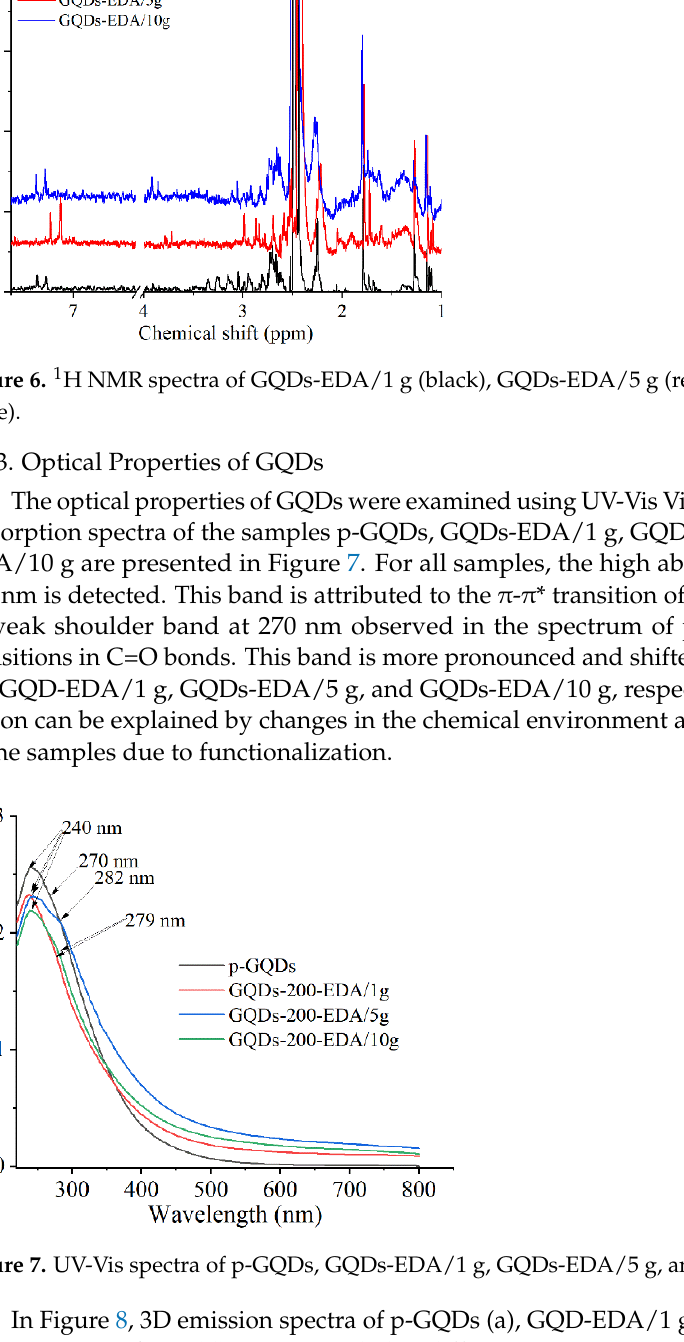
Figure 7. UV-Vis spectra of p-GQDs, GQDs-EDA/1 g, GQDs-EDA/5 g, and GQDs-EDA/10 g.